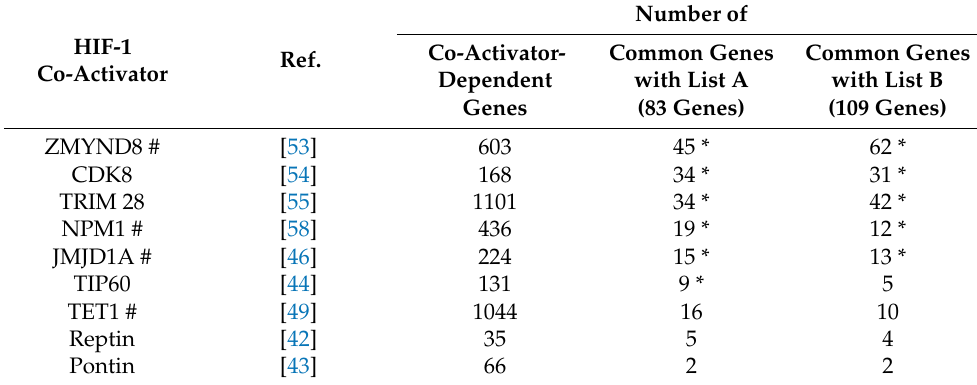
Table 2. Comparative analysis of HIF-1-interacting co-activator-dependent gene target dataset with List A and List B of HIF-1-dependent gene targets.